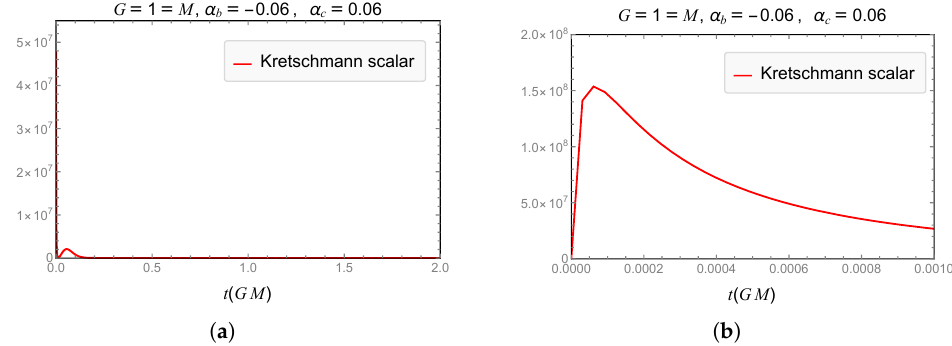
Figure 21. K in GUP model 3. ( a ) The Kretschmann scalar K for model 3 as a function of the Schwarzschild time t . ( b ) Close up of K close to t = 0. It is seen that K remains finite everywhere in the interior and vanishes for t =